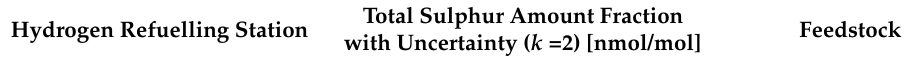
Table 4. Summary of total sulphur amount fraction in 11 hydrogen fuel samples determined by cryo-focussing GC-SCD analysis; abbreviation explanation: n.a.: not available; SMR: steam methane reforming; NG: natural